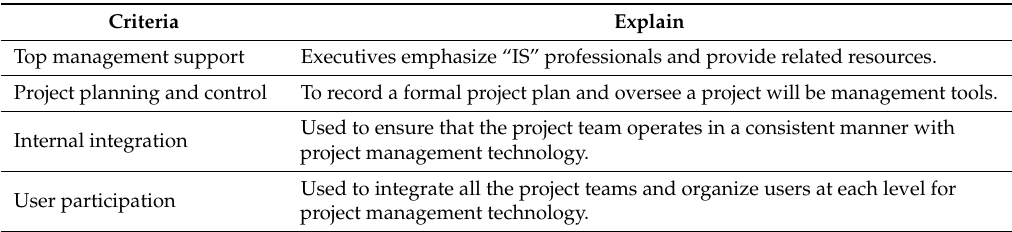
Table 2. Explanation of project management criteria.